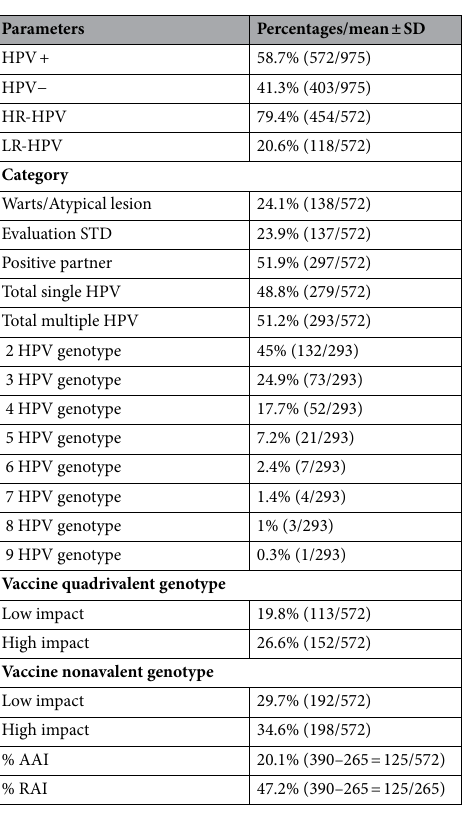
Table 1. General characteristics of 572 positive HPV patients. LR low risk, HR high risk, AAI absolute additional impact, RAI relative additional